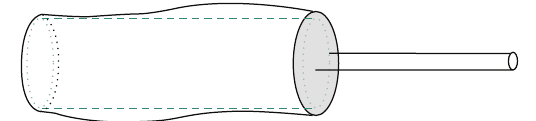
Figure 5: Three-dimensional and one-dimensional coupling